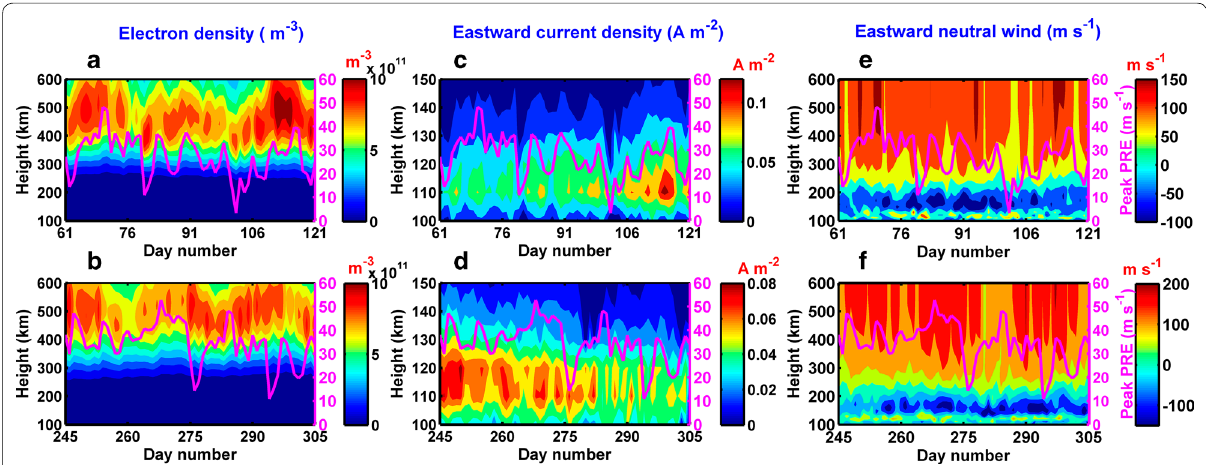
Fig. 2 Day-to-day variations of the peak PRE (magenta line) and a , b electron density, c , d eastward current density, and e , f eastward neutral wind at the time when the PRE reached a peak during (top) March–April and (bottom) September–October in 2012 over (10° N, 100° E; GAIA co-ordinates) near Chumphon in